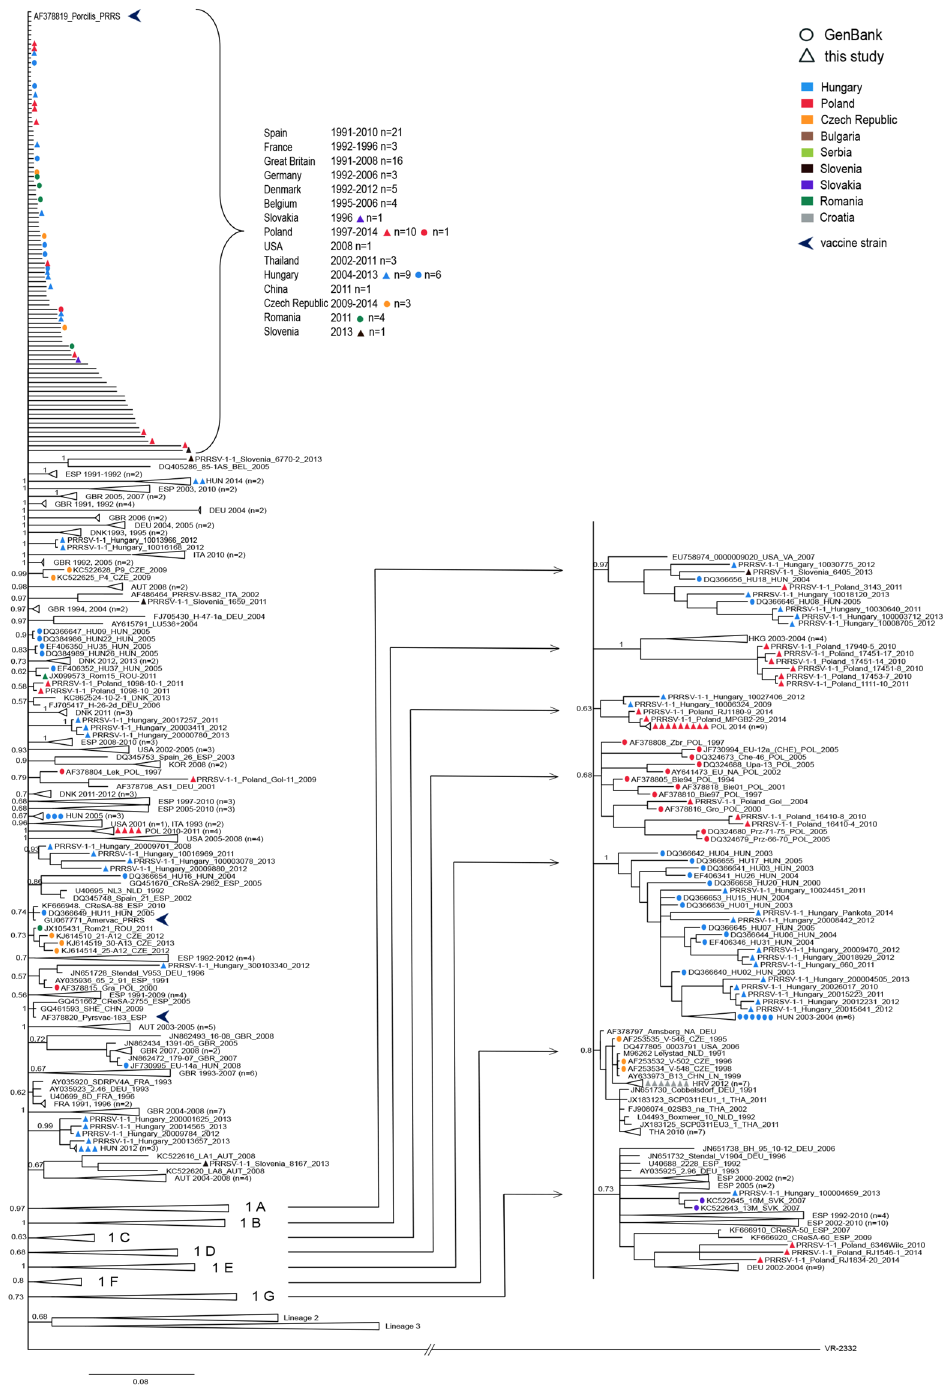
Figure 3. Phylogenetic tree of lineage 1 based on ORF5 sequences constructed in MrBayes 40 . PRRSV 2 prototype strain VR2332 (AY150564) was used as an outgroup. Some minor clusters were collapsed for clarity. Geographical origin and year of isolation were indicated for each sequence. Details of sequences from 1A–1 G clades were shown in the side panel. Posterior probability values supporting main nodes were